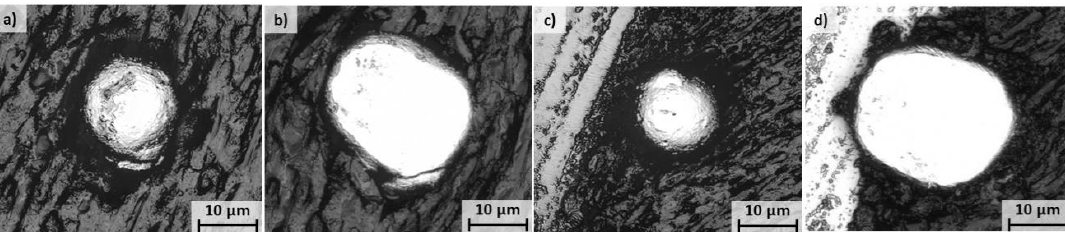
Figure 2. Examples of confocal microscopy images of the particles: ( a , b ) particle #5, ( c , d ) particle #3 (dimensions given in Table 1) before ( a , c ) and after ( b , d ) deformation, respectively.